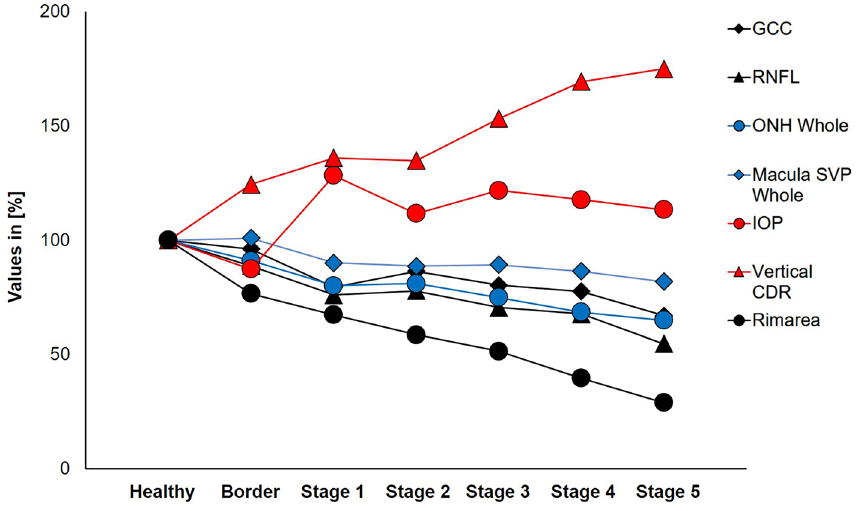
Figure 1. OCT and OCT-A parameter vs. OCT staging. Values from GCC, RNFL in [µm], IOP in [mmHg], ONH Whole in [%], Macula SVP Whole in [%], vertical CDR and rim area in [mm 2 ] for the healthy stage were set to 100%. Values for the other stages (borderline, stage 1–5) were normalized to the healthy stage and are displayed in [%].